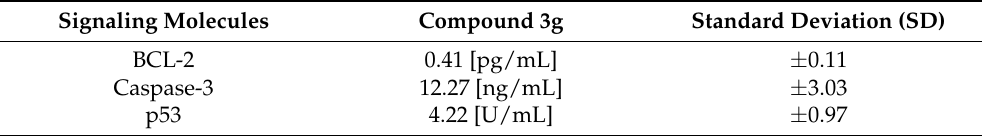
Table 2. The changes in the expression of selected signaling molecules induced by 3g in cultures of the colon adenocarcinoma cell line